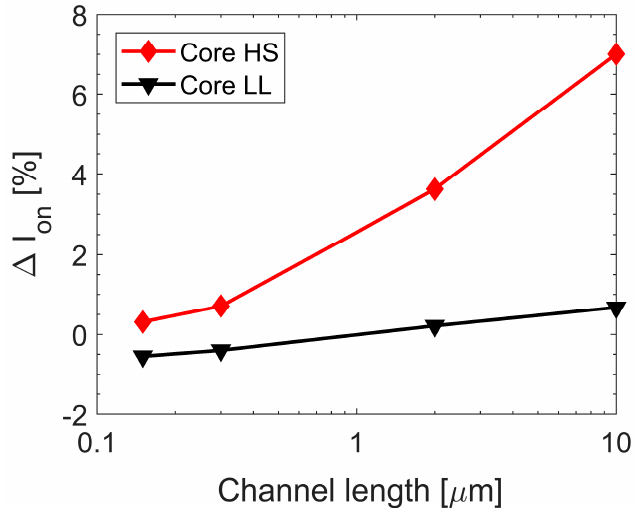
Figure 8. Evidence of the channel length dependence of the TID effects in core transistors. The changes in the drain current are plotted at 125 krad(SiO 2 ) as a function of channel length ( L ) in nMOSFETs with the same narrow channel W = 0.32 µ